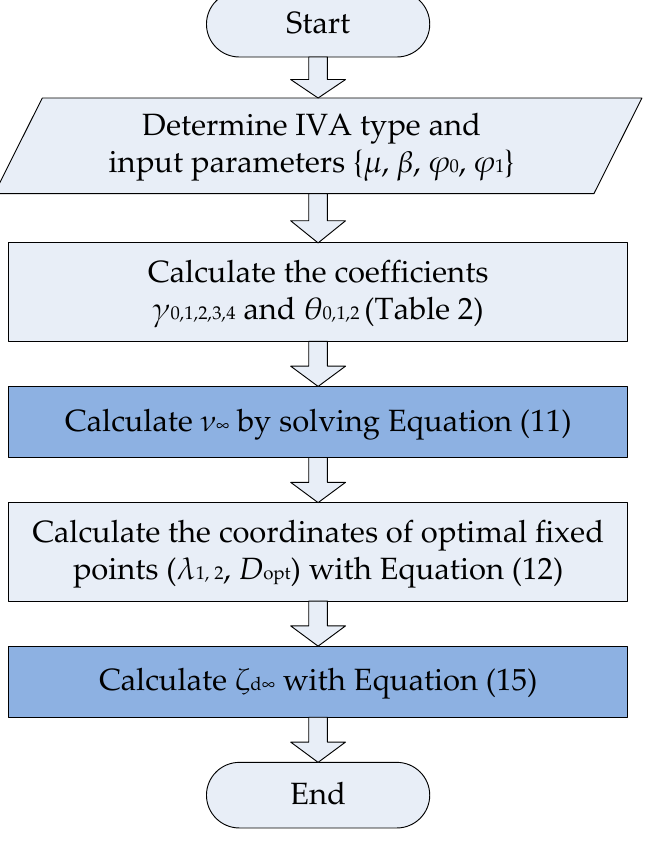
Figure 3. A flow chart for determining the analytical optimal parameters via FPA (the procedures that output optimal parameters are highlighted). Table 3. Analytical solutions to the optimal parameters { ν ∞ , ζ on